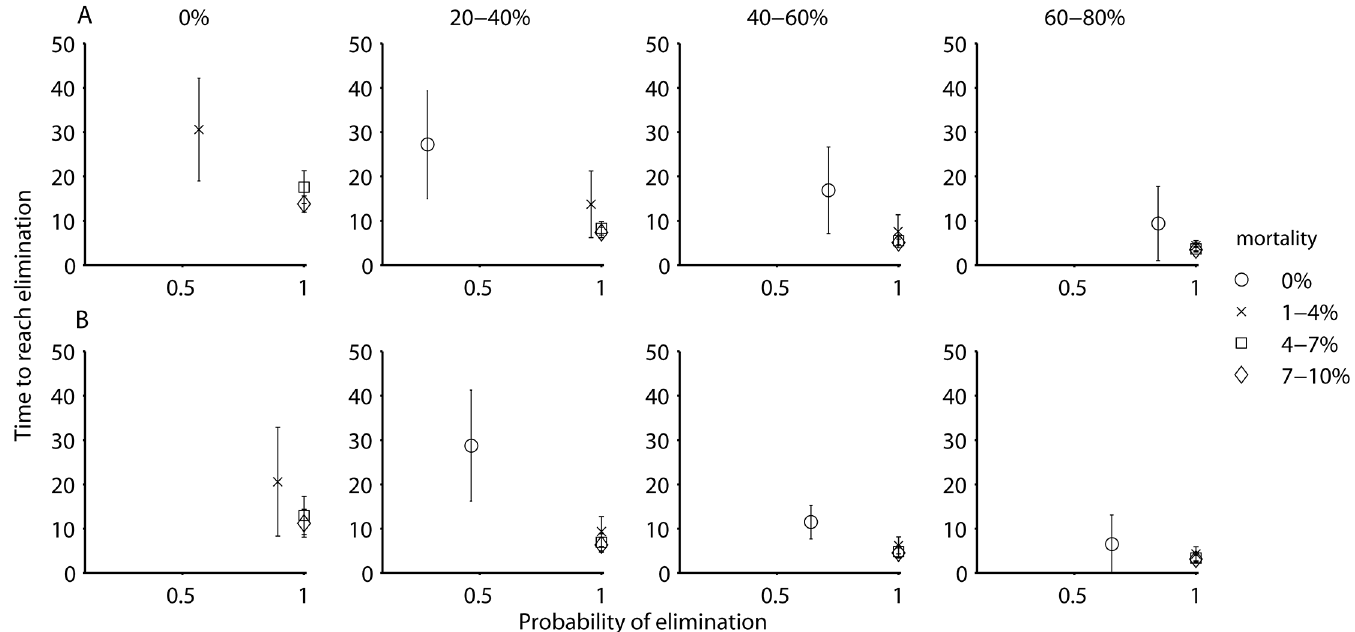
Fig 7. The proportion of simulations where HAT was eliminated (i.e., prevalence < 1 x 10 − 6 ) and the mean time to elimination, depending on the percentage of the human population screened per year, with varying levels of vector control (expressed as additional vector mortality, indicated by the symbols in the legend), for a low transmission setting without an animal reservoir (A) and with an animal reservoir